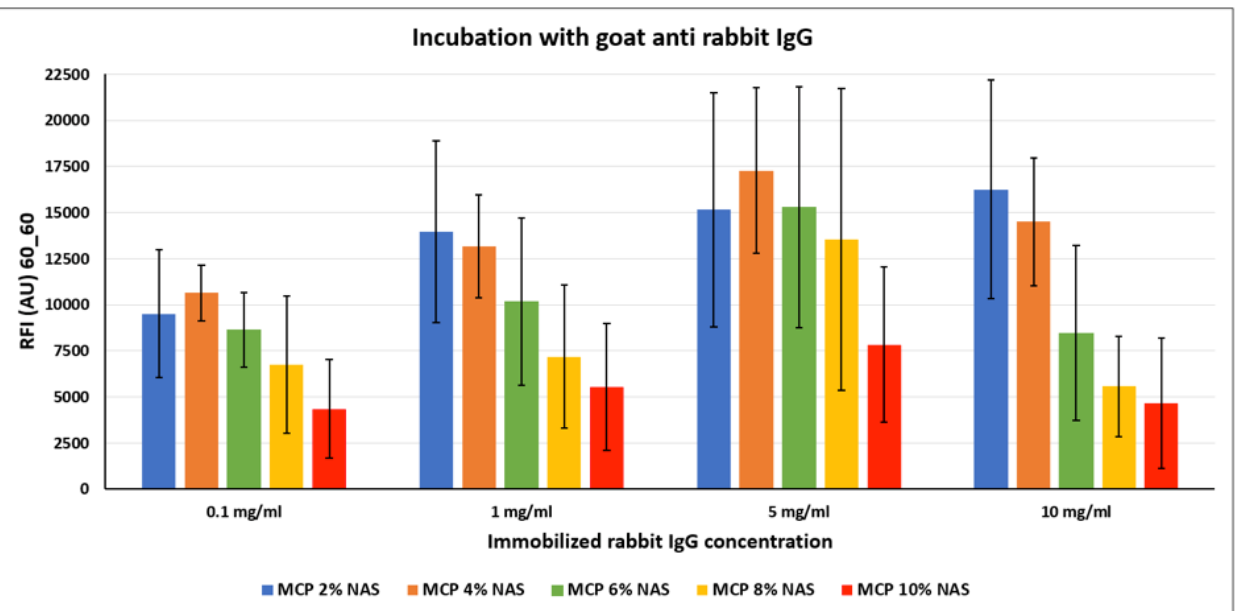
Figure 6. Fluorescence intensity signals obtained on silicon slides coated with MCP NAS polymers, spotted with increasing concentrations of rabbit IgG and incubated with a Cy3-labelled goat anti-rabbit IgG. Fluorescence was measured with a confocal laser scanner with power set at 60% and the photomultiplier tube gain (PMT) at 60%. The reported signal intensities are the average of the Relative Fluorescence Intensity (RFI) of each 10 × 2 subarray, each corresponding to a single rabbit IgG concentration. Therefore, the error bars are the standard deviations of the fluorescence intensity of 20 spots.